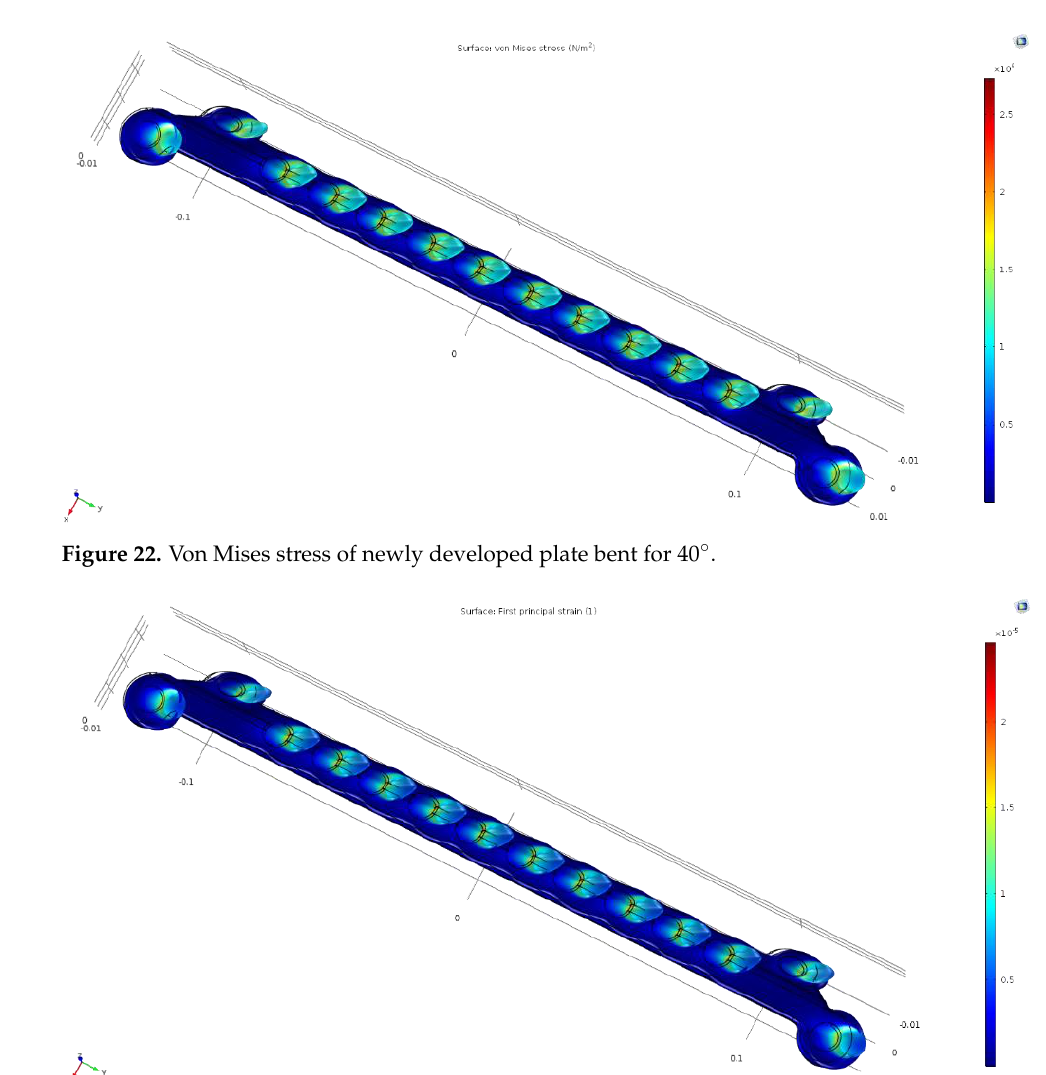
Figure 21. Total displacement of newly developed plate bent for 40°.